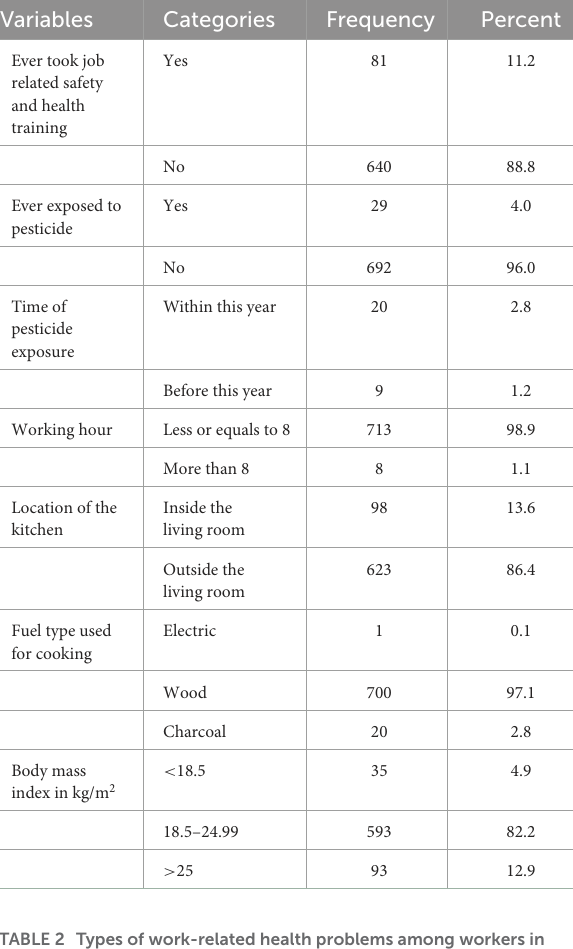
TABLE 3 Types of work related disease symptoms among workers in coffee industries, Bench-Sheko and Kafa Zones,